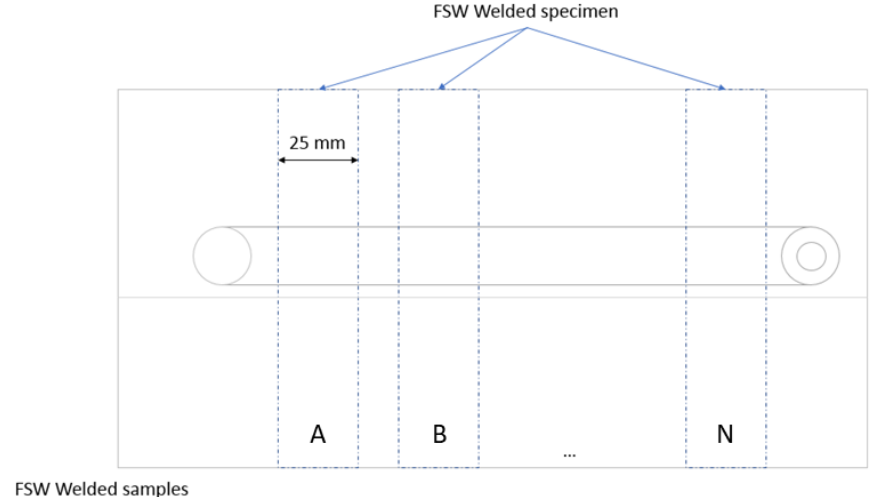
Figure 10. Tensile and fatigue tests samples. Table 4. Shear test